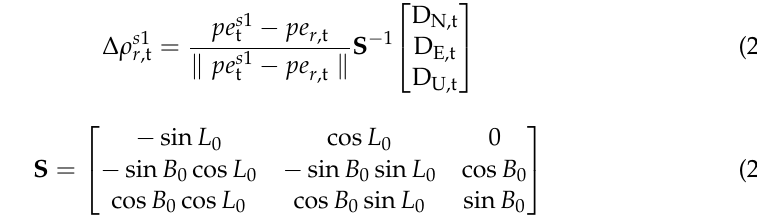
Figure 2. Illustration of NCCU station. The observation interval is 30 s (i.e., 2880 epochs per day). This study gives a masking condition, in which an azimuth cutoff, from 90° to 270°, is used to present a situation where the station is mounted on the wall. Under this masking condition, the number of